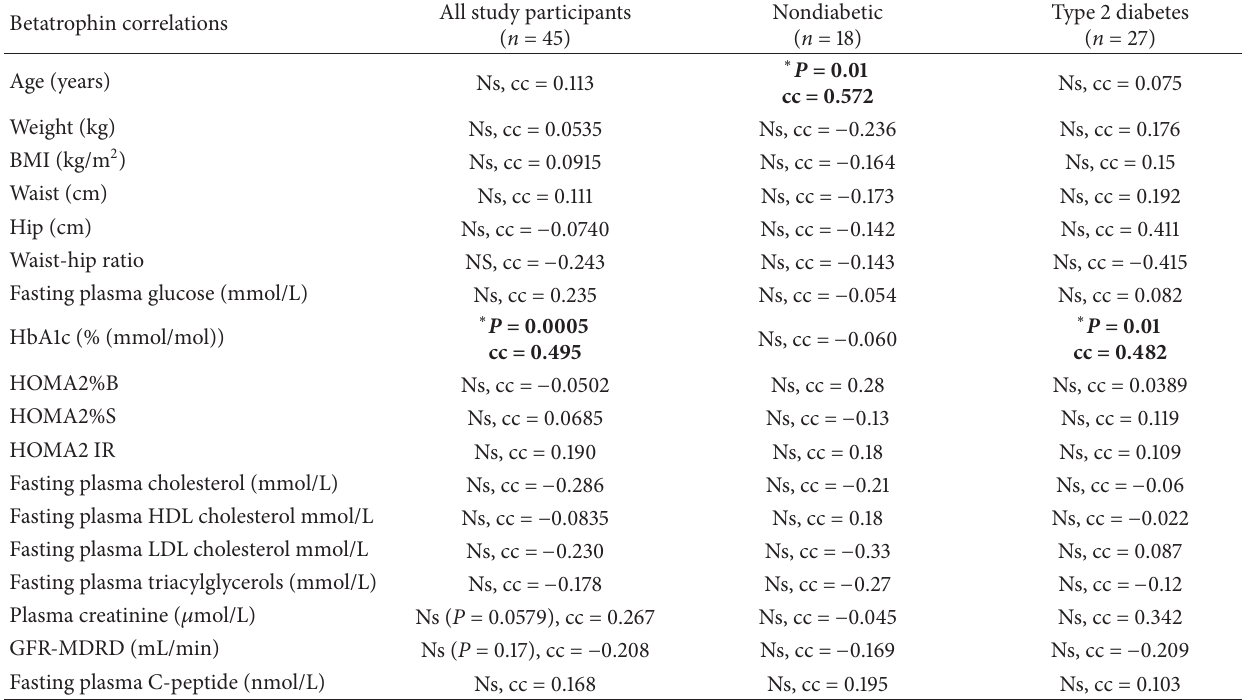
Table 2: Correlations between betatrophin levels and other variables in all study participants, nondiabetic controls, and patients with type 2 diabetes. Correlations were computed with Pearson product